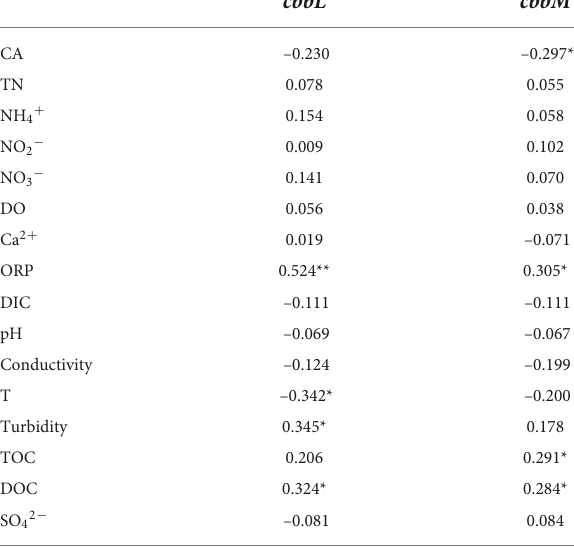
TABLE 3 Results of the correlation analysis between carbon-fixing gene abundances and various environmental factors in the Huixian karst